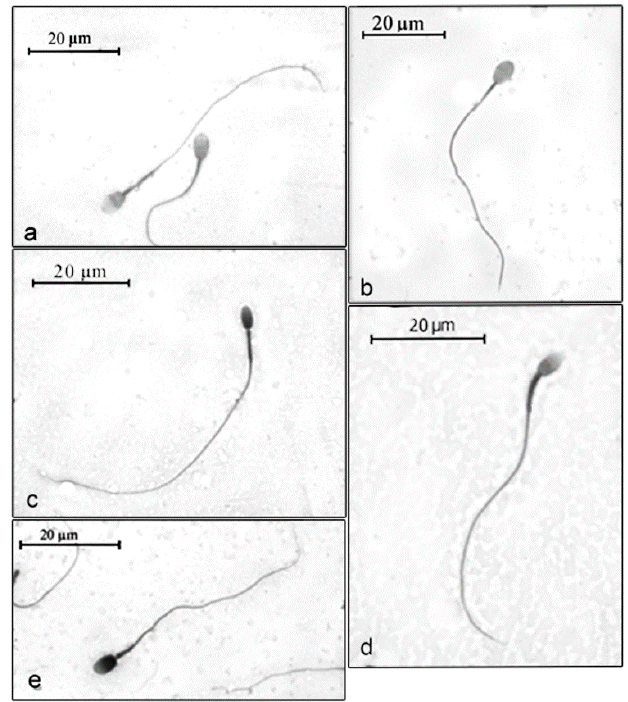
Figure 1. Microphotographs of spermatozoa from the studied neotropical primates. ( a ) Cebus cay ( = Sapajus cay ); ( b ) Cebus nigritus ( = Sapajus nigritus ); ( c ) Ateles belzebuth ; ( d ) Ateles chamek ; ( e ) Alouatta caraya . Most of the measurements di ff ered significantly among species (One-Way ANOVA, p <